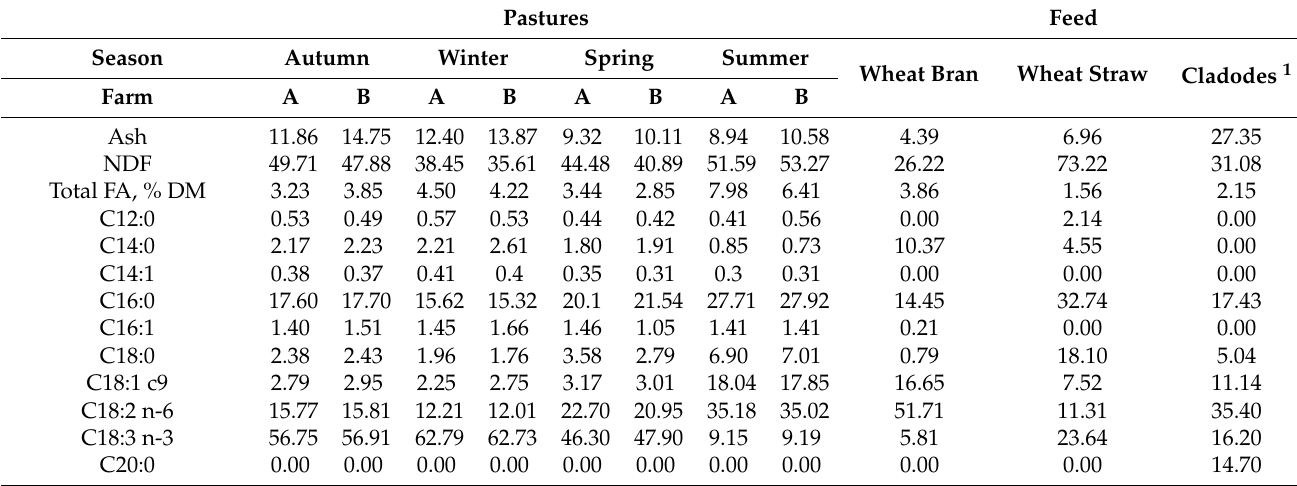
Table 2. Cont. Pastures